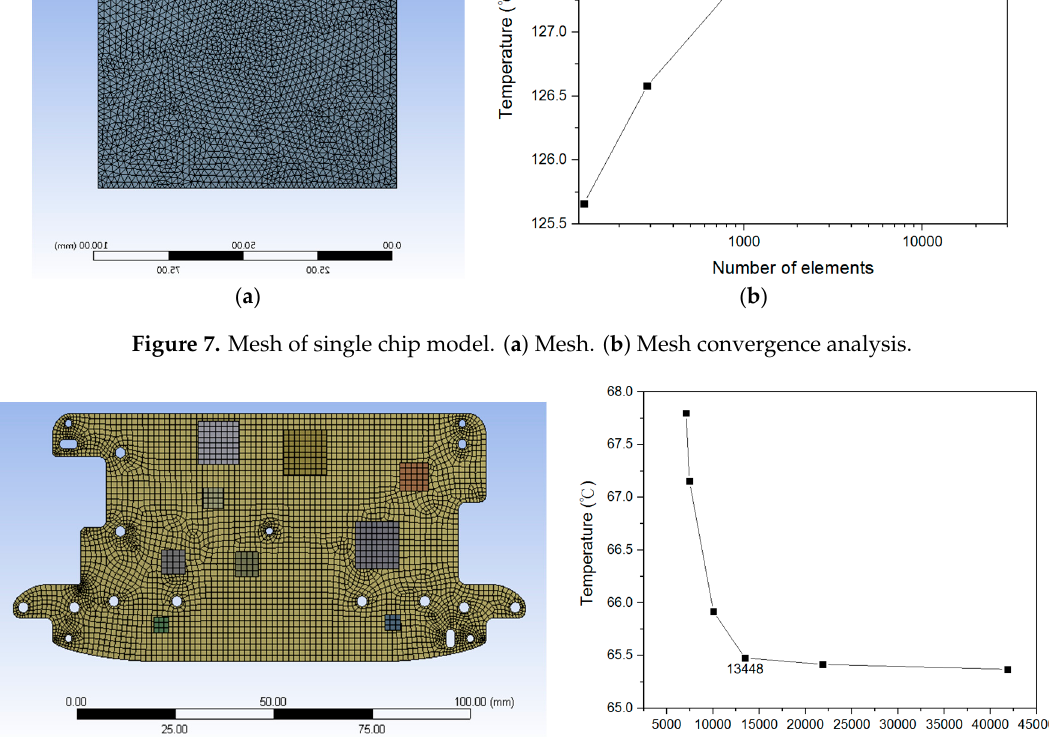
Figure 8. Mesh of PCBA model. ( a ) Mesh. ( b ) Mesh convergence analysis.